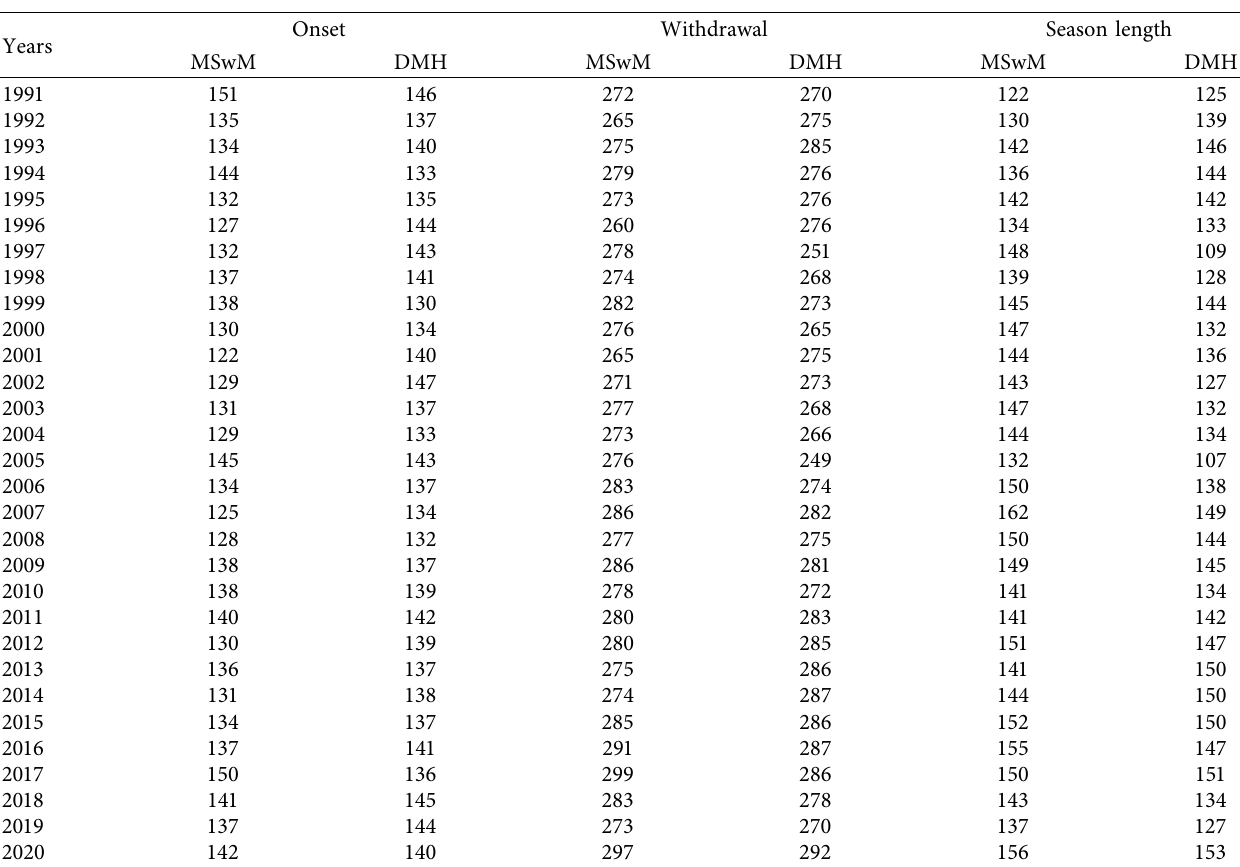
Table 2: Composite of year-wise onset and withdrawal dates, season length of southwest monsoon over Myanmar as determined by the MSwM index and the DMH index,